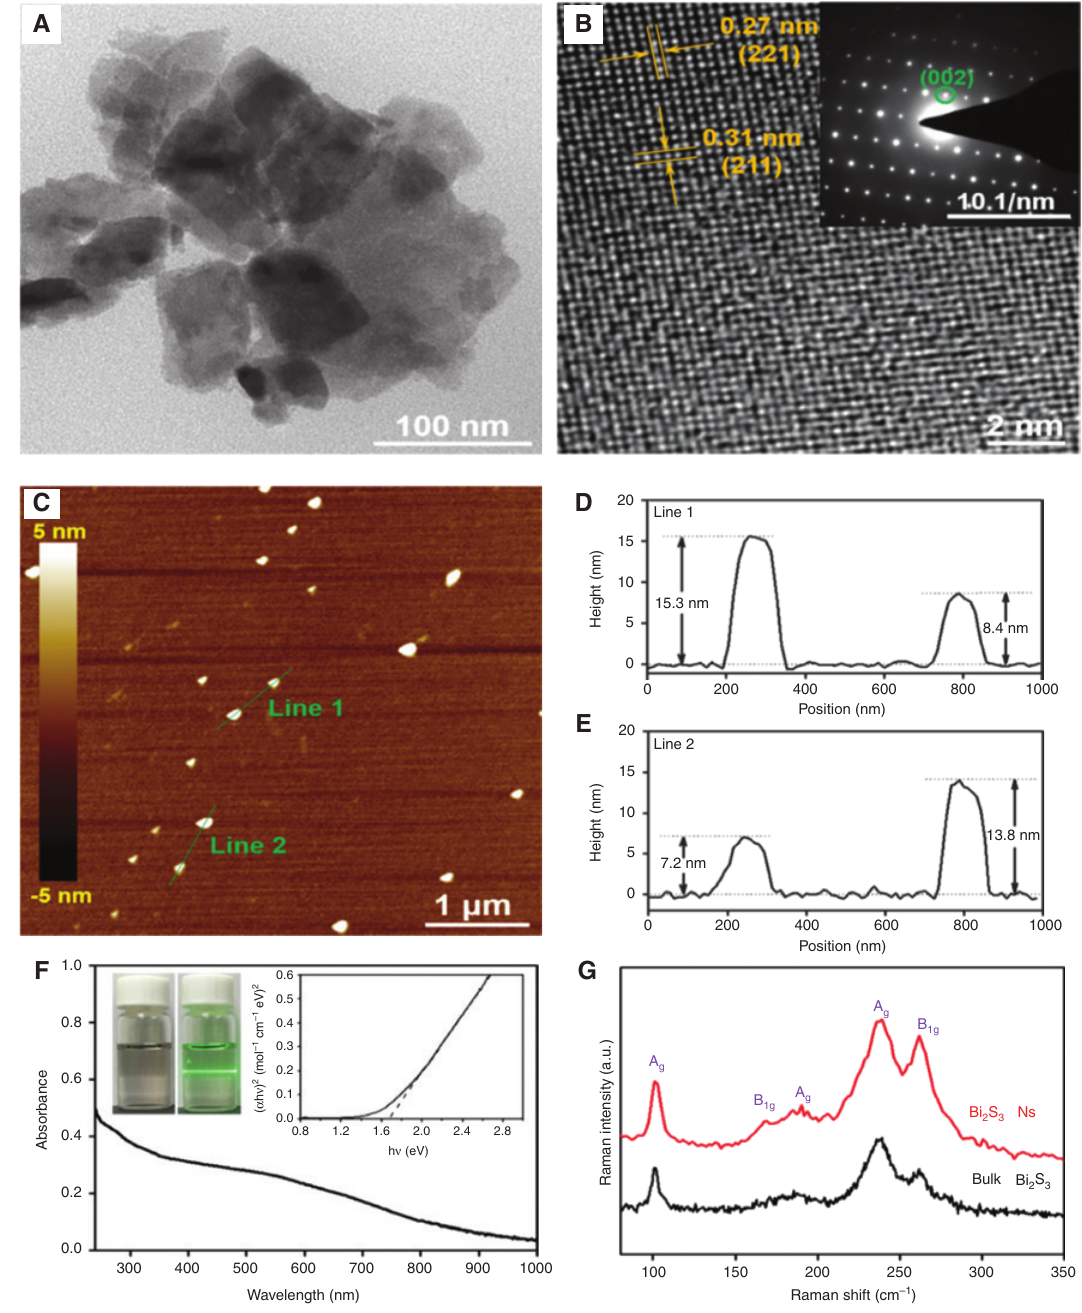
S nanosheets. Figure 1: Structural characterization of the as-prepared Bi 2 3 (A) TEM image of the Bi S nanosheets. (B) HRTEM image showing crystalline lattices. Inset: The selected area electron diffraction (SAED) 2 3 pattern (up right). (C) AFM image of the Bi S nanosheets. (D, E) Height profiles along the green lines in (C). (F) UV-Vis absorption spectrum 2 3 of the Bi S nanosheets in NMP. Left inset: Photos of the Bi S nanosheet suspension (left) and the Tyndall effect of the Bi 2 3 2 3 suspension (right); right insert: Tauc plot for its calculation of the band gap ( E ) energy. (G) Raman spectra of bulk Bi g